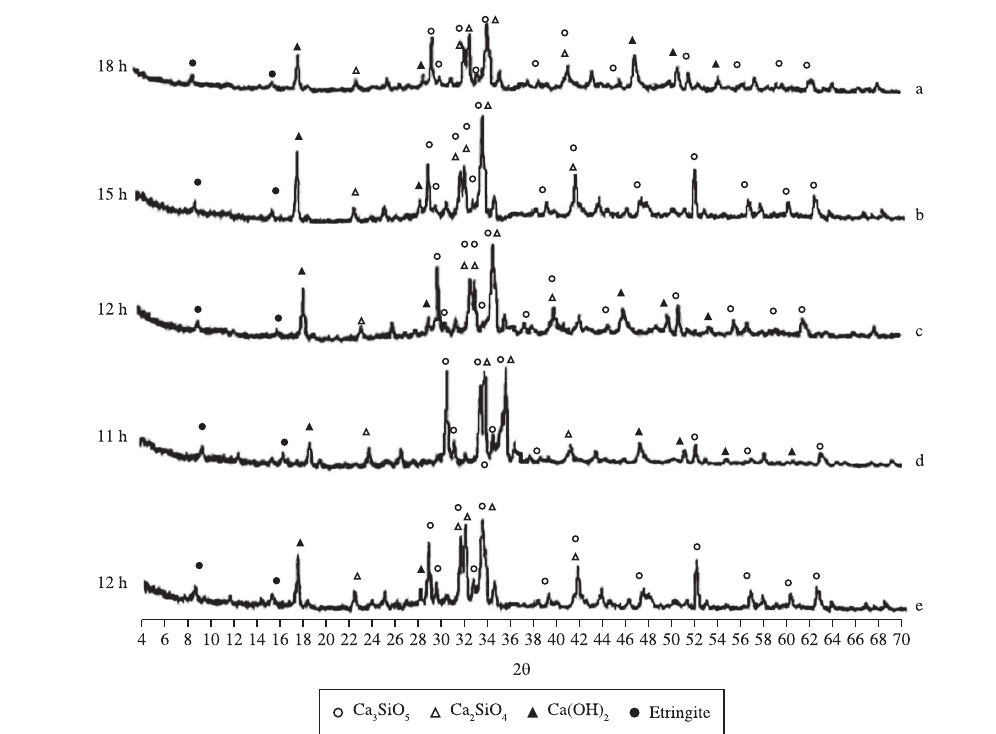
Figure 8. XRD results indicating the formation of hydrated products for different N-SCC specimens: a) N1-SCC1; b) N2-SCC1; c) N3-SCC1; d) N4-SCC1; and e)